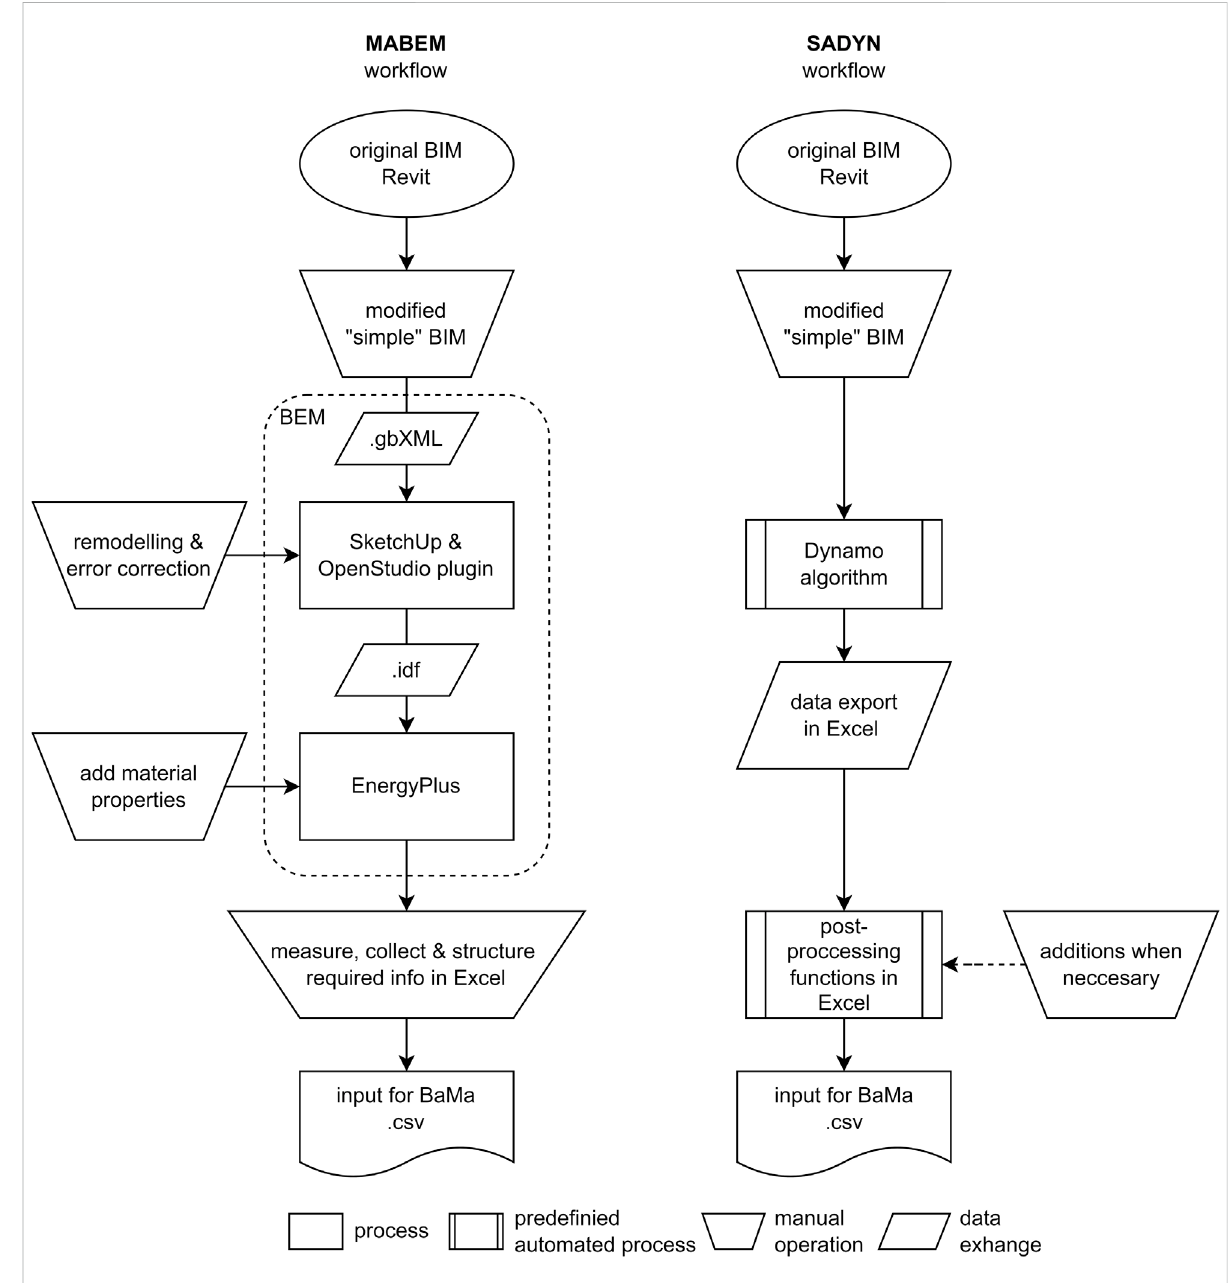
FIGURE 5 Work fl ows: (left) manual BEM-based data acquisition – MABEM, (right) semi-automated dynamo-based data acquisition – SADYN.